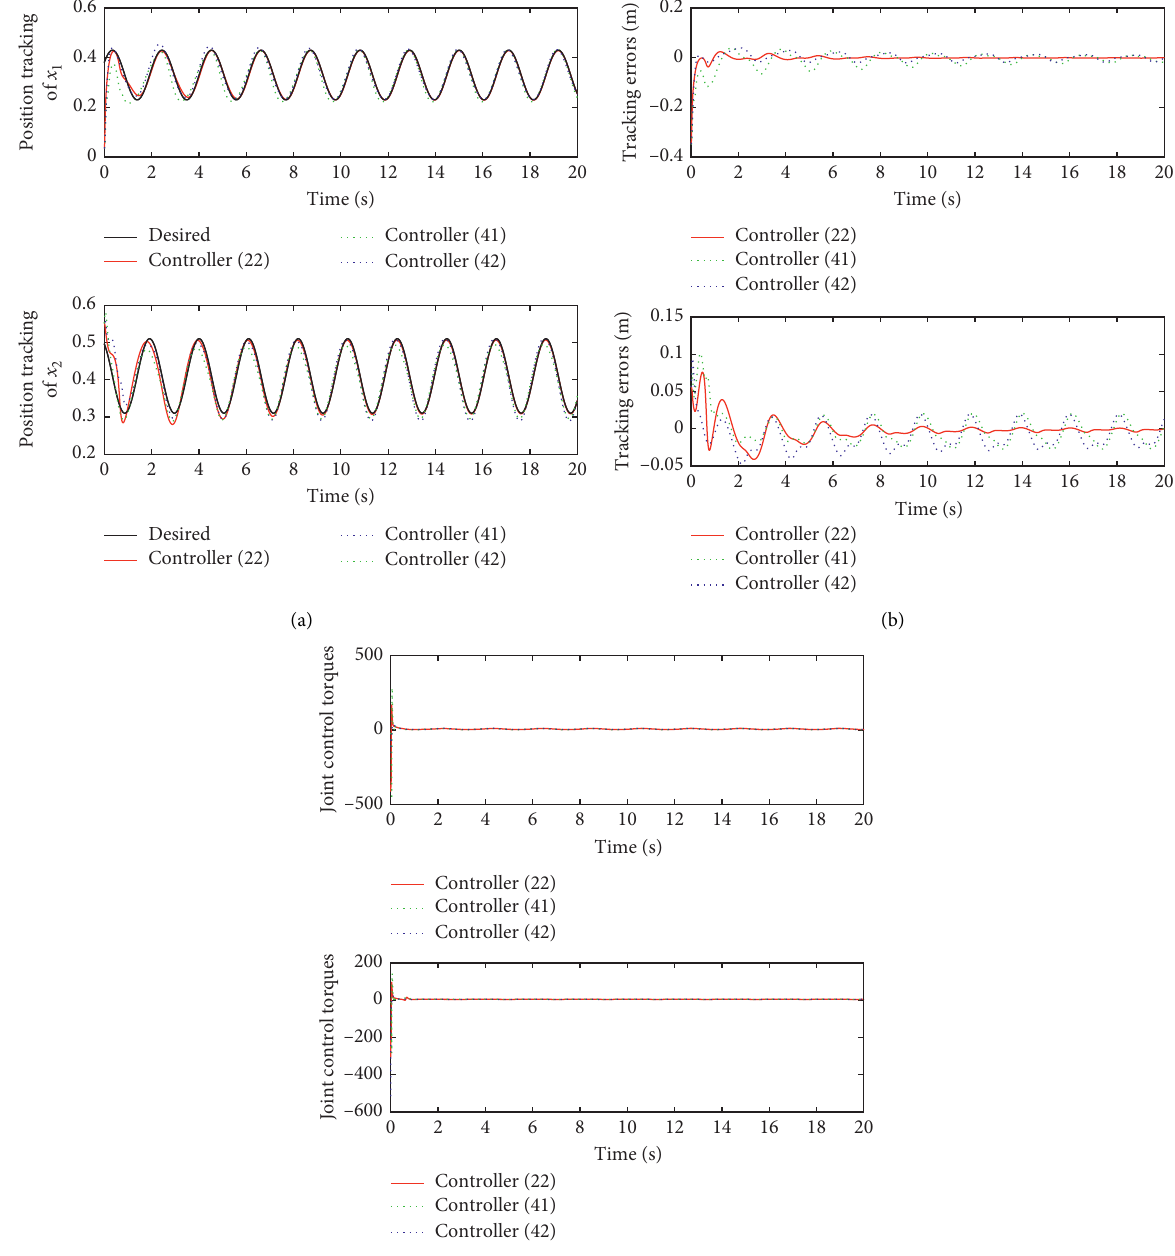
Figure 2: Comparisons of end-effector position tracking performance. (a) Comparisons of tracking performance. (b) Comparisons of tracking errors. (c) Comparisons of control